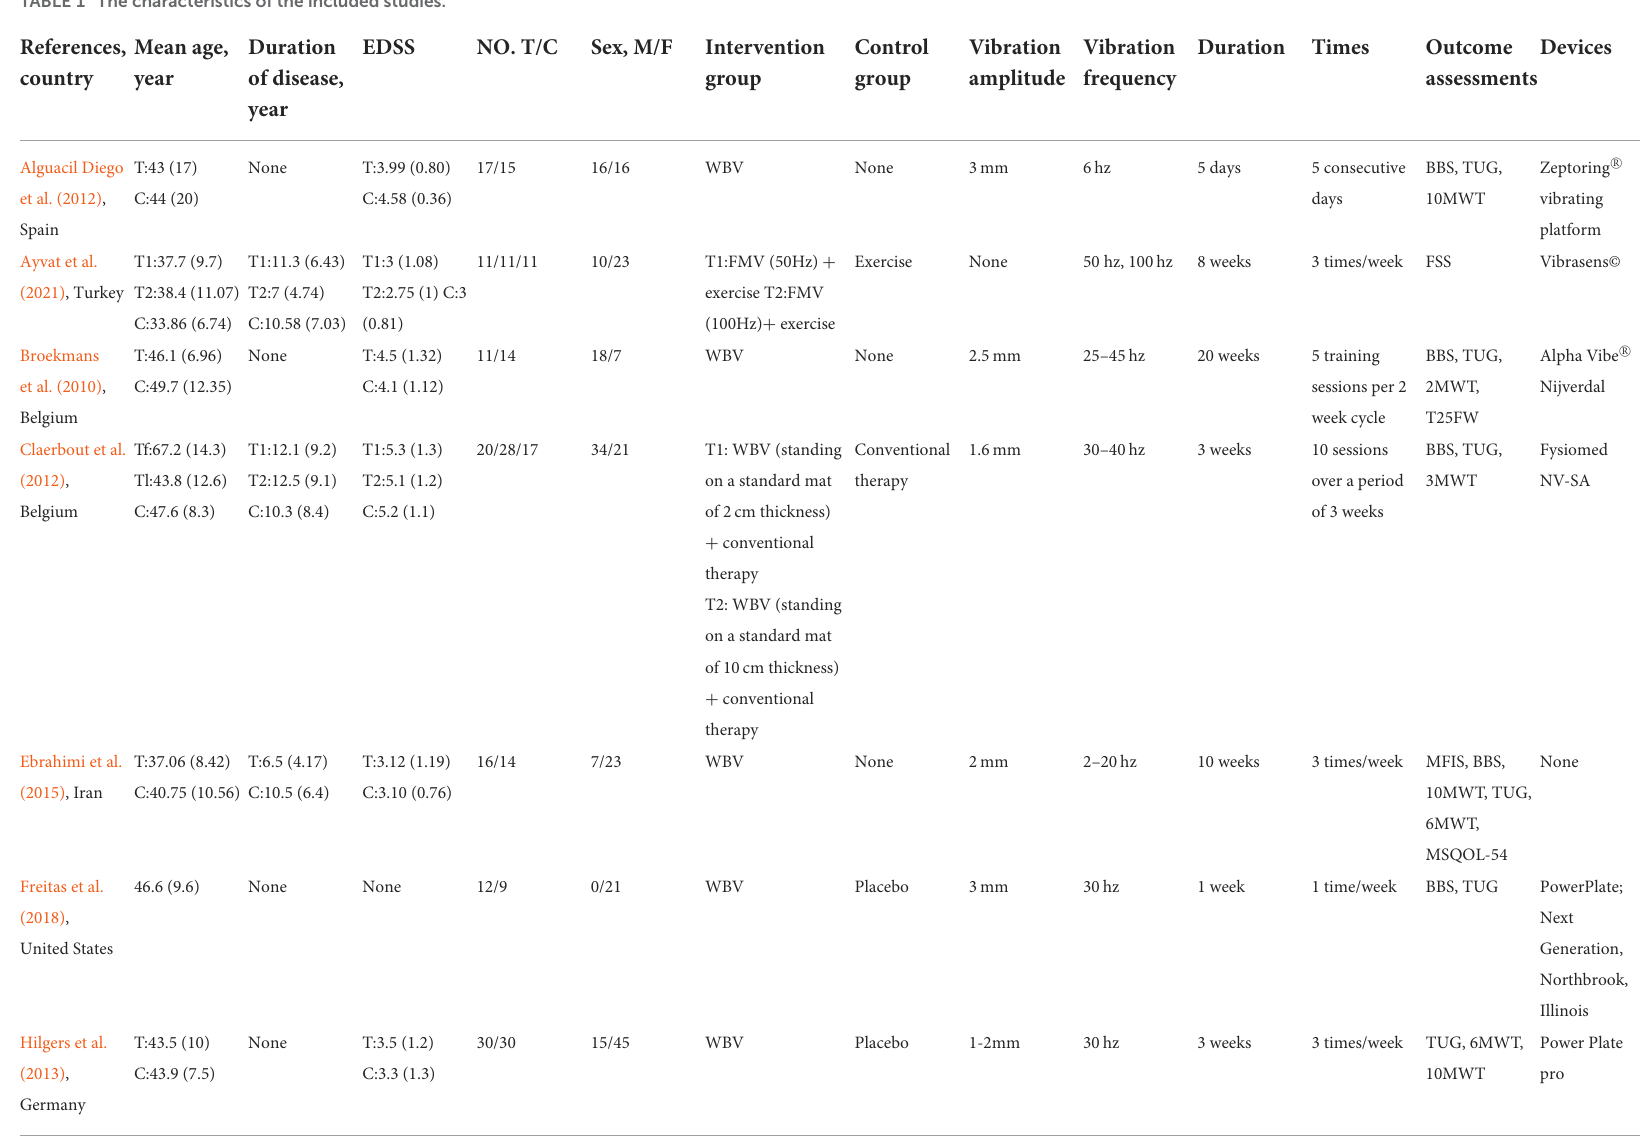
TABLE 1 The characteristics of the included